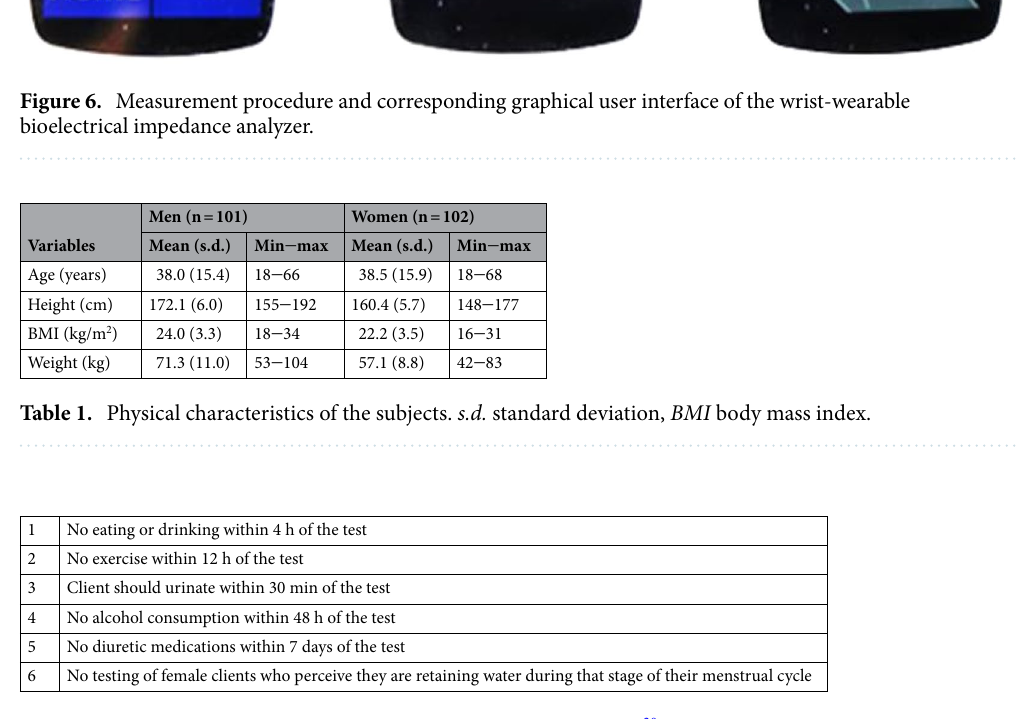
Table 2. Bioelectrical impedance analysis client pretesting guidelines 20